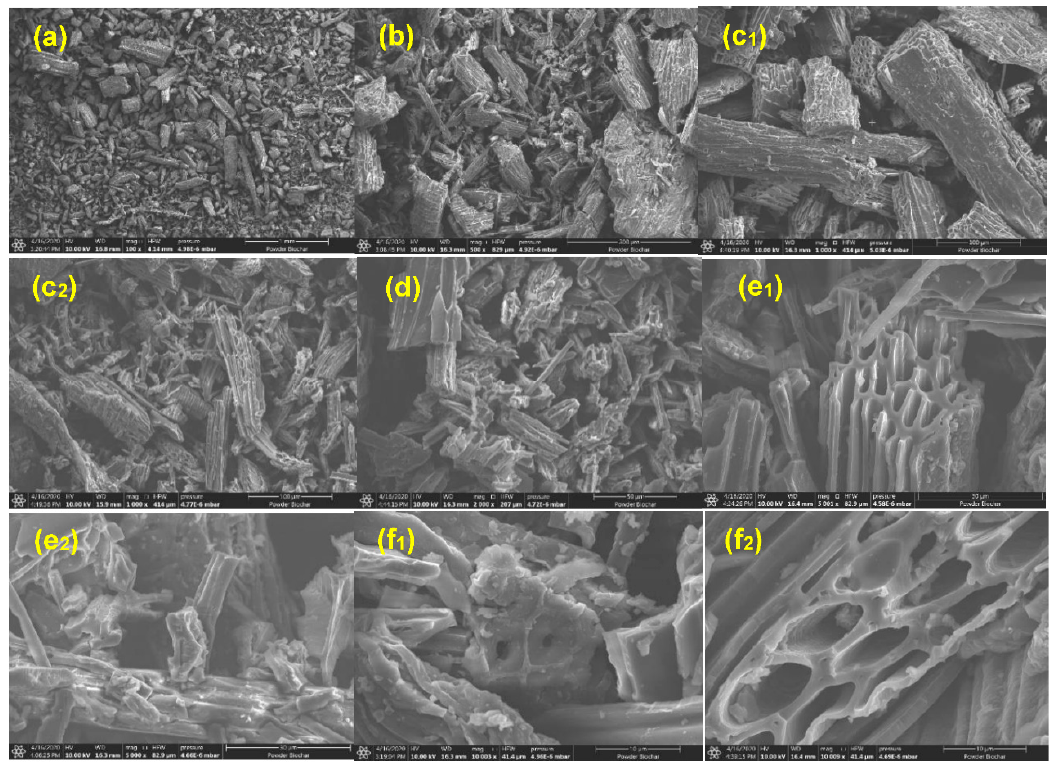
Figure 3. Scanning electron microscopy image of powder biochar at different magnification and scale: ( a ) 100× mag—1-mm scale; ( b ) 502× mag—300-µm scale; ( c 1 ) 1000× mag—100-µm scale; ( c 2 ) 1000× mag—100-µm scale; ( d ) 2000× mag—50-µm scale; ( e 1 ) 5001× mag—30-µm scale; ( e 2 ) 5000× mag—30-µm scale; ( f 1 ) 10,001× mag—10-µm scale; ( f 2 ) 10,000× mag—10-µm scale.